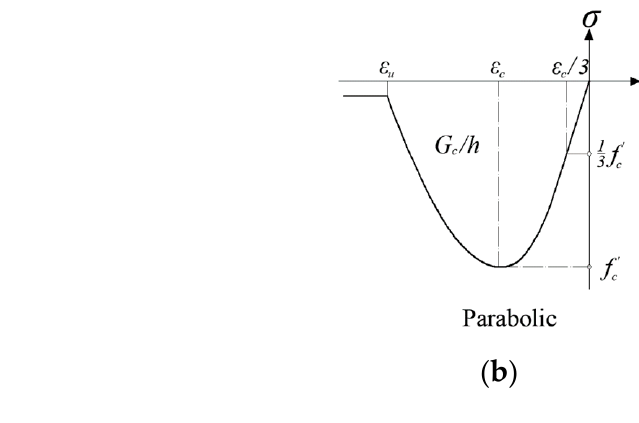
Figure A1. Model for concrete: ( a ) predefined tensile stress–strain curve; ( b ) predefined compressive stress–strain curve.